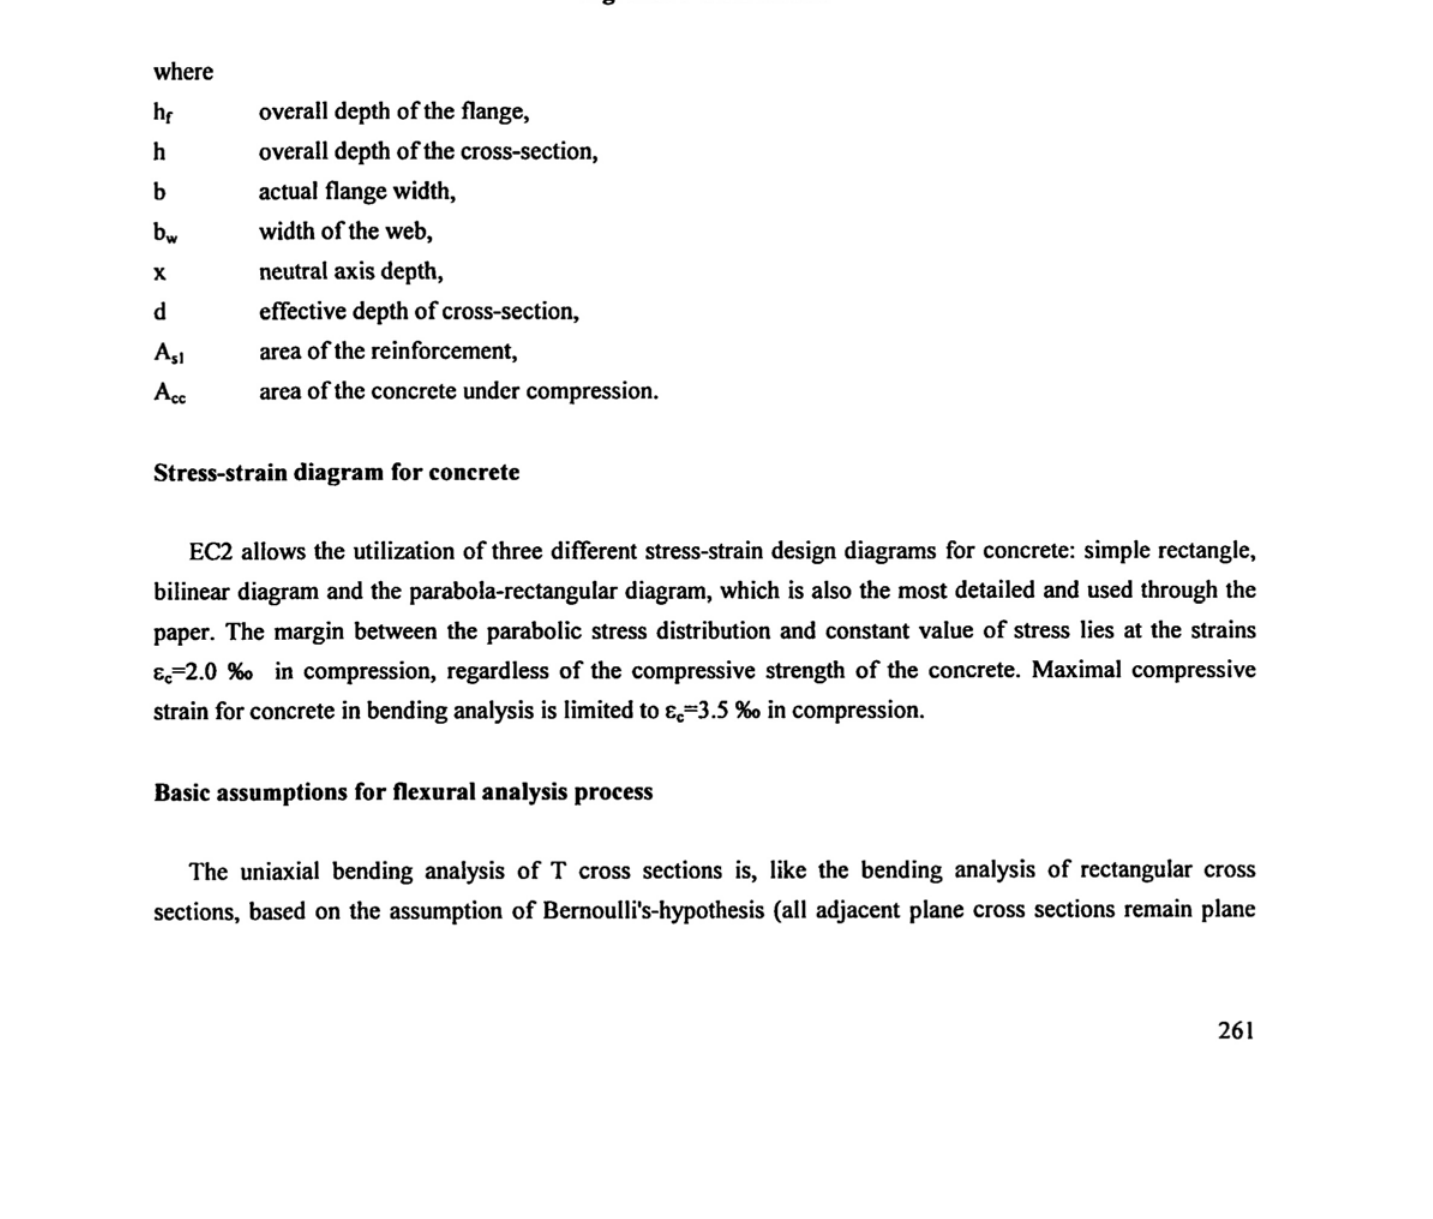
Fig. 1 : A T cross